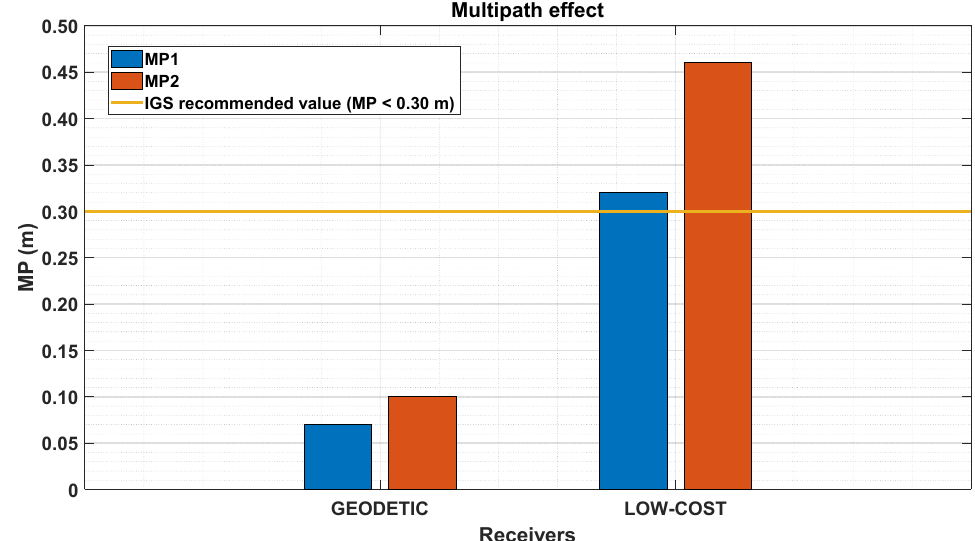
Figure 4. Multipath effect for the low-cost and geodetic GNSS receivers. Yellow line: IGS recom- mended value (MP < 0.3 m).